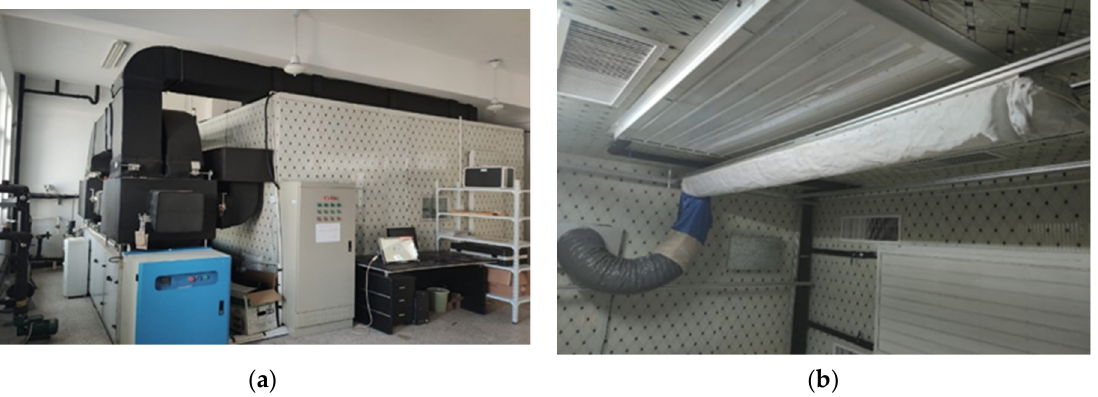
Figure 4. ( a ) The experimental platform of the experimental cabin. ( b ) Internal layout of the experi- mental cabin. Table 1. The main experimental equipment and accuracy. Instruments and